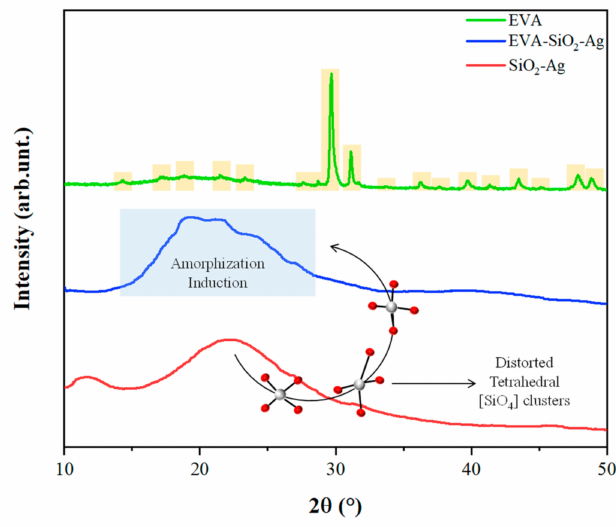
Figure 1. X-ray diffractograms of SiO 2 -Ag, EVA-SiO 2 -Ag, and EVA